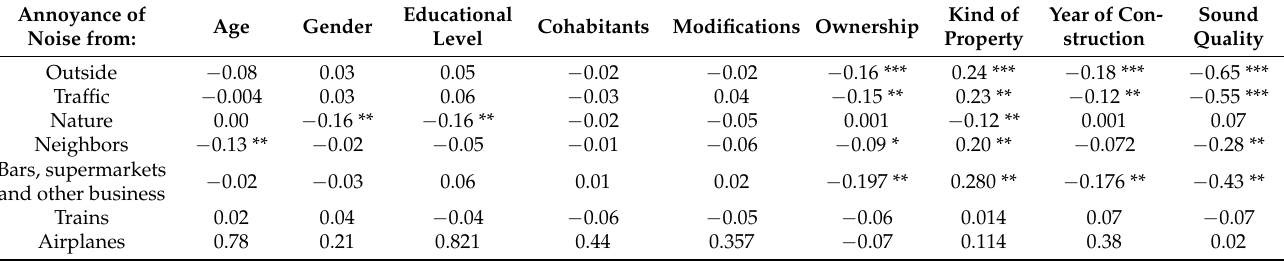
Table 2. Correlations of the sociodemographic data and noise annoyance before lockdown. Annoyance of Noise